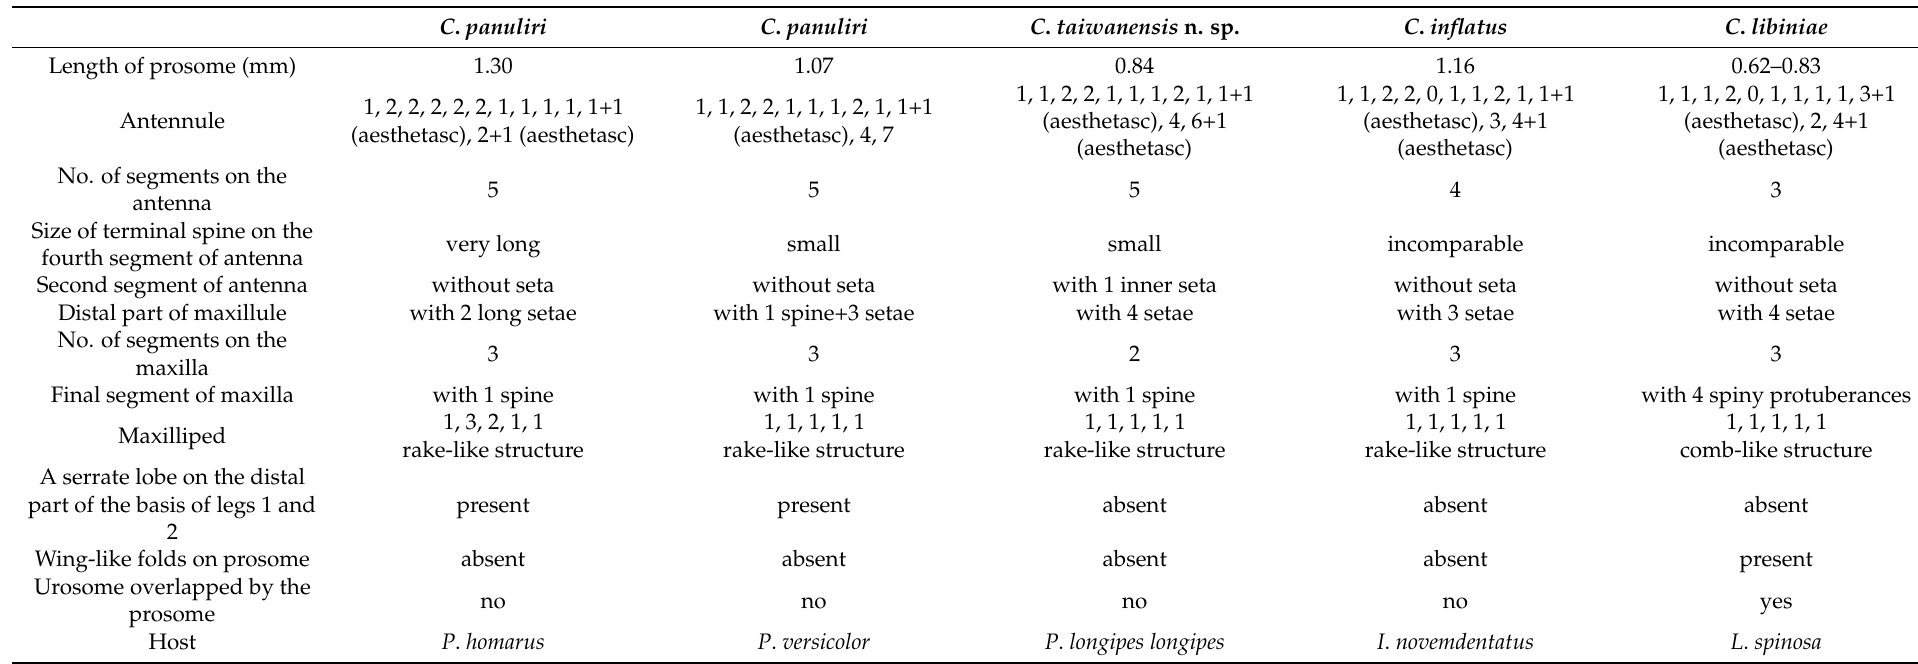
Table 2. Comparison of morphological features among Choniomyzon taiwanensis n. sp. and its congeners ( Choniomyzon panuliri , Choniomyzon libiniae , and Choniomyzon inflatus